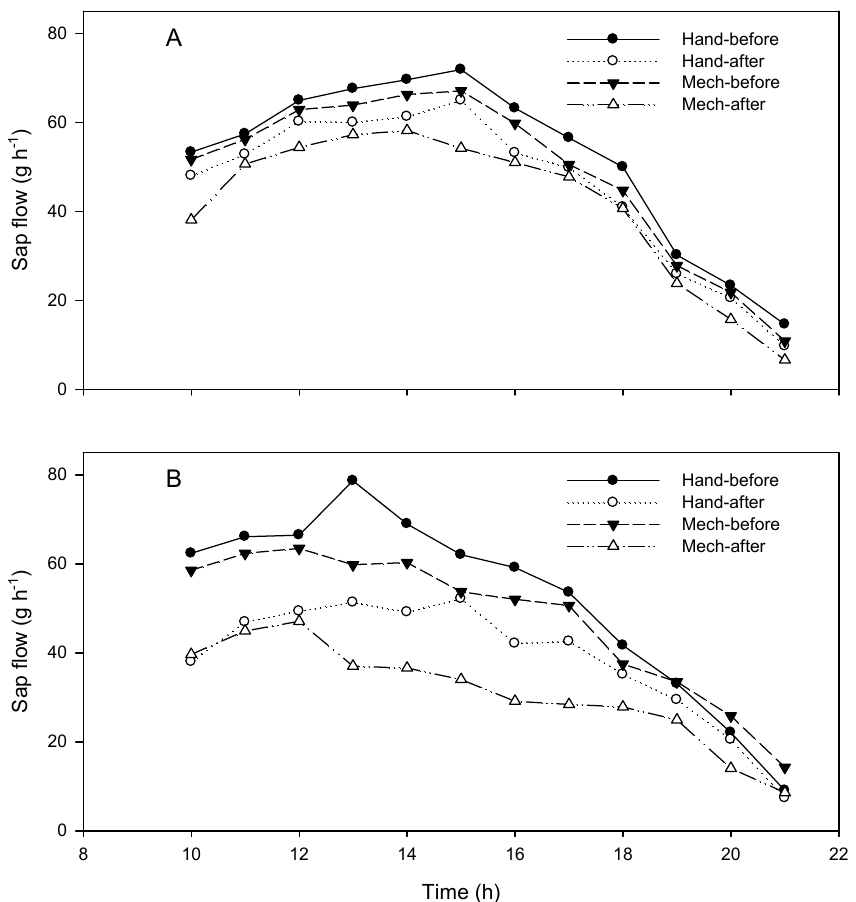
Figure 2. Effect of harvesting methods (Hand and mechanical canopy shaker) on hourly sap flow measurements in ( A ) and ( B ) experiments before and after harvesting respectively at the commercial site in southwest Florida during 2015.